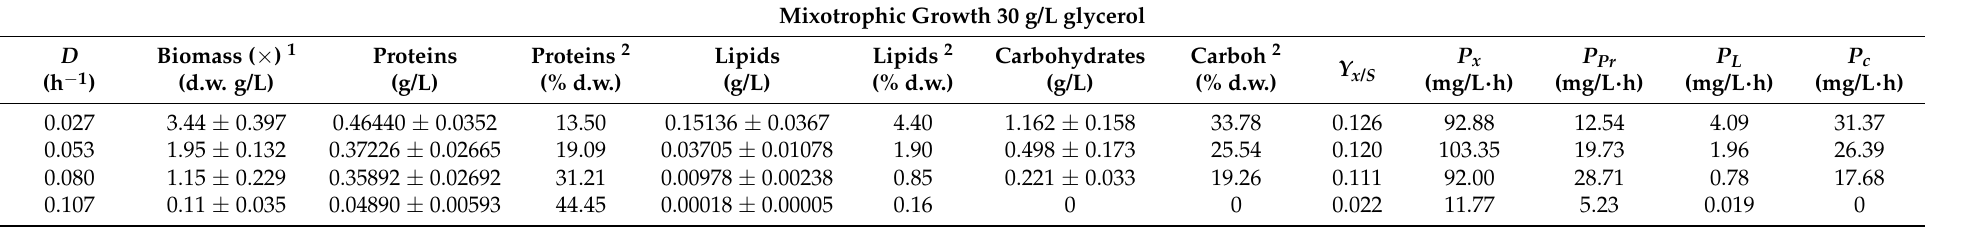
Table 3. Values of biomass, protein, lipids and carbohydrates production (means ± SD) in a continuous flow culture of A. protothecoides with 30 g/L glycerol under mixotrophic conditions at steady state situations atn various D . The productivities of biomass ( P x ) and metabolites ( P Pr for proteins, P L for lipids, and P c for carbohydrates) and Y x/S were calculated by the equations: P x = D · x , P m = D · m and Y x/S = x/S asimilated ,